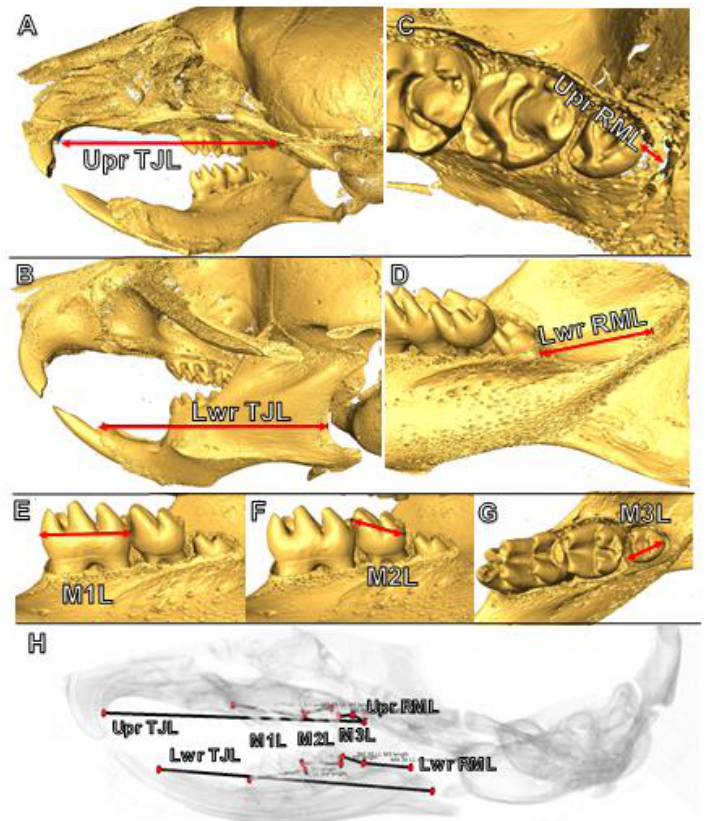
Figure 1. Linear measurements used to define jaw and molar lengths in ( A ) embryonic (E12) and ( B ) perinatal (E18) mice for total jaw length in the upper and lower jaws. Retromolar length is not yet visible in the embryo ( A ). Abbreviations: Lwr, lower jaw; M1L, first molar length, M2L, second molar length, M3L, third molar length; RML, retromolar length; TJL, total jaw length; Upr, upper jaw.